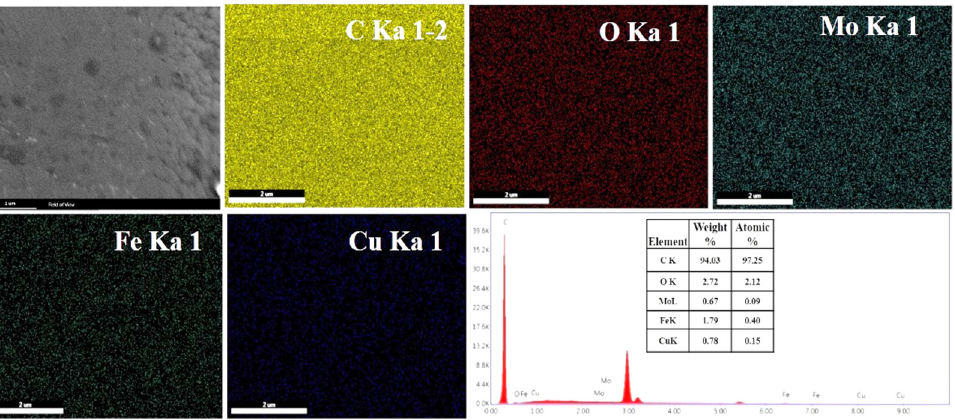
Figure 12. EDS results of wear track of steel/DLC friction pair under PAO6 + 0.1 wt.% Cu lubrication.